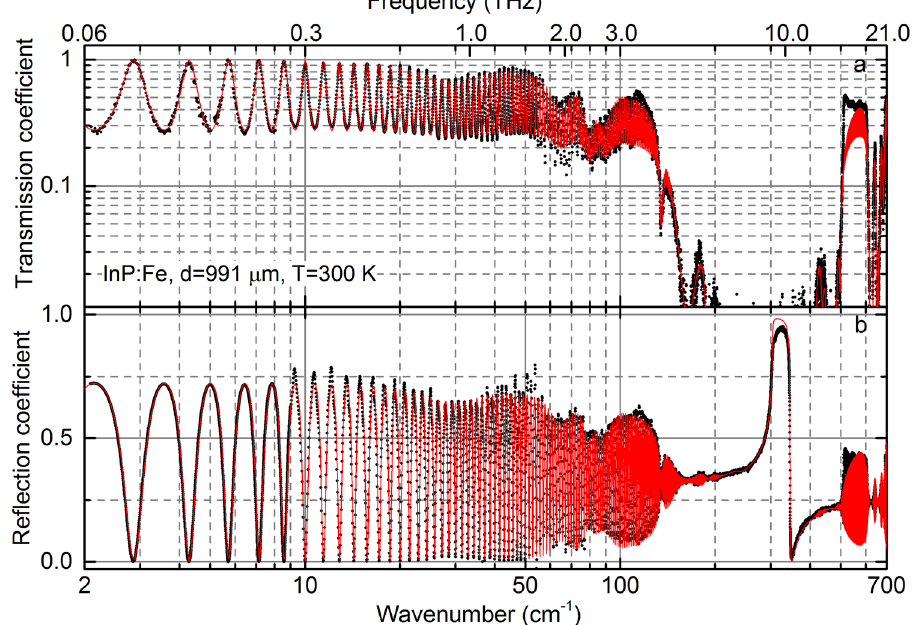
Figure 1. Room-temperature transmission ( a ) and reflection ( b ) spectra of semi-insulated Fe-doped InP wafer of 991 µ m thickness. Black dots are the experimental data, red solid lines present theoretical modeling described in the main